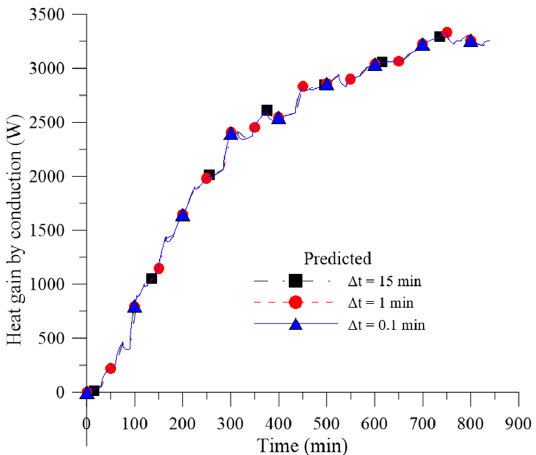
Figure 19. Conduction heat gain by the thermal insulation as a function of the time for different time steps.